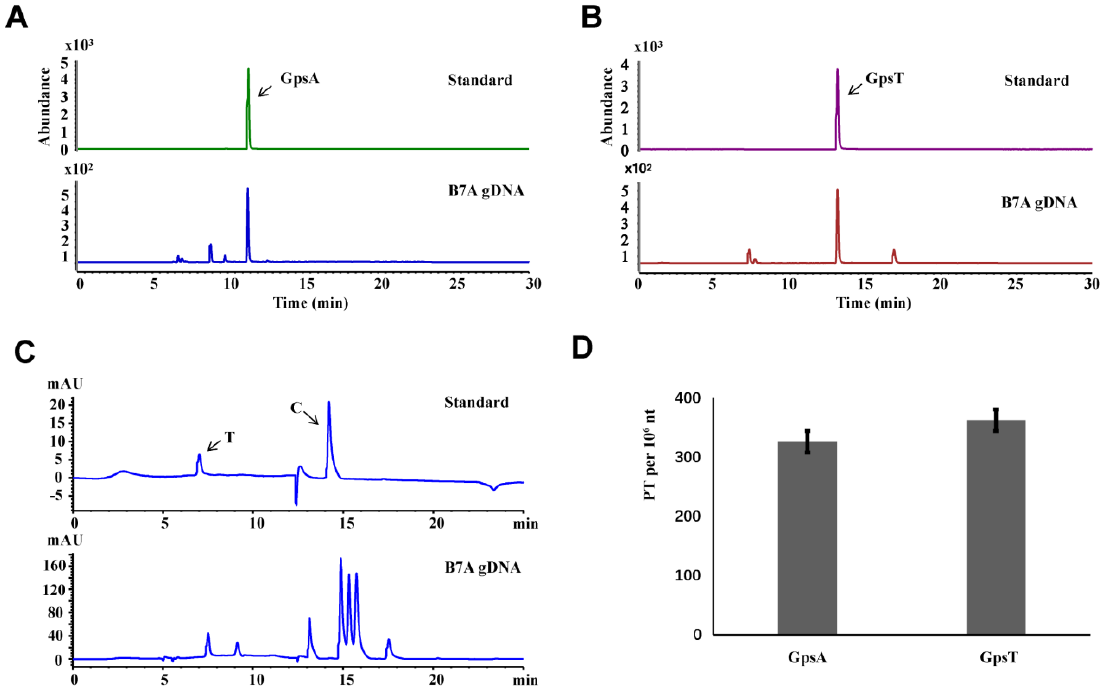
Figure 3. Quantitative analysis of genomic PT modification by LC-MS / MS. ( A , B ) LC-MS / MS analysis of the PT-linked dinucleotides from E. coli B7A. ( C ) HPLC analysis of gDNA from E. coli B7A. ( D ) The number of PT-modified dinucleotides per 10 6 nt of DNA in E. coli B7A. Error bars are calculated as the s.d. of three independent biological replicates.